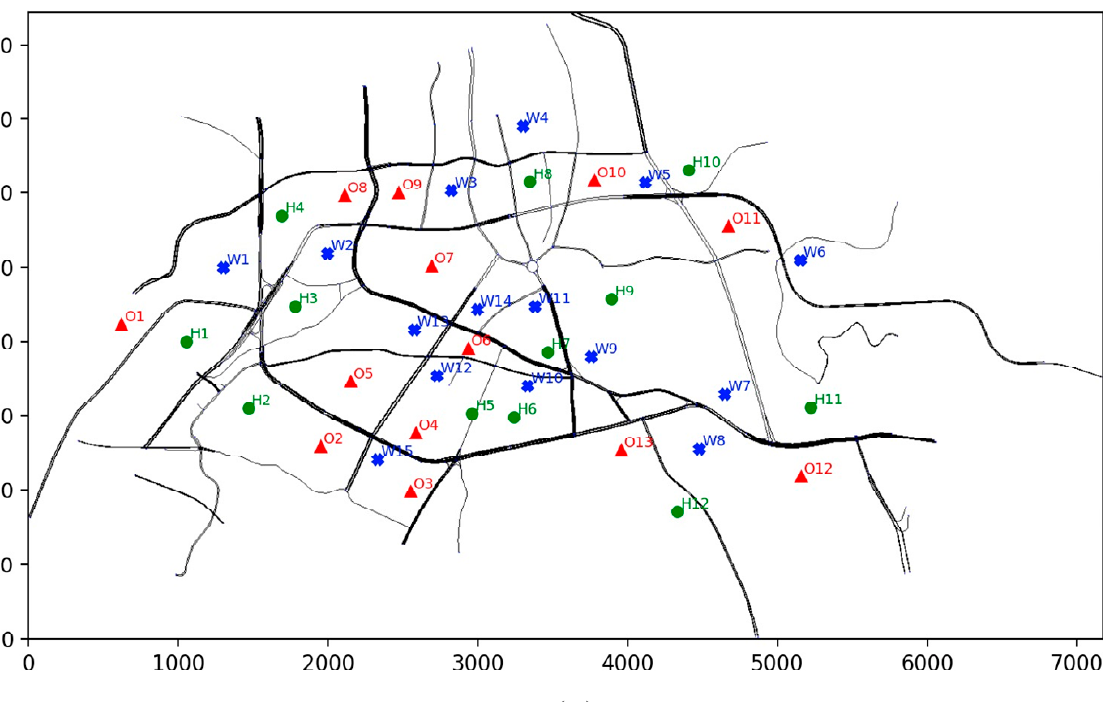
Figure 4. Actual distribution network topology and charging station service area. Table 1. Maximum number of parking spaces in each block. Block Maximum Num- ber of Parking Spaces